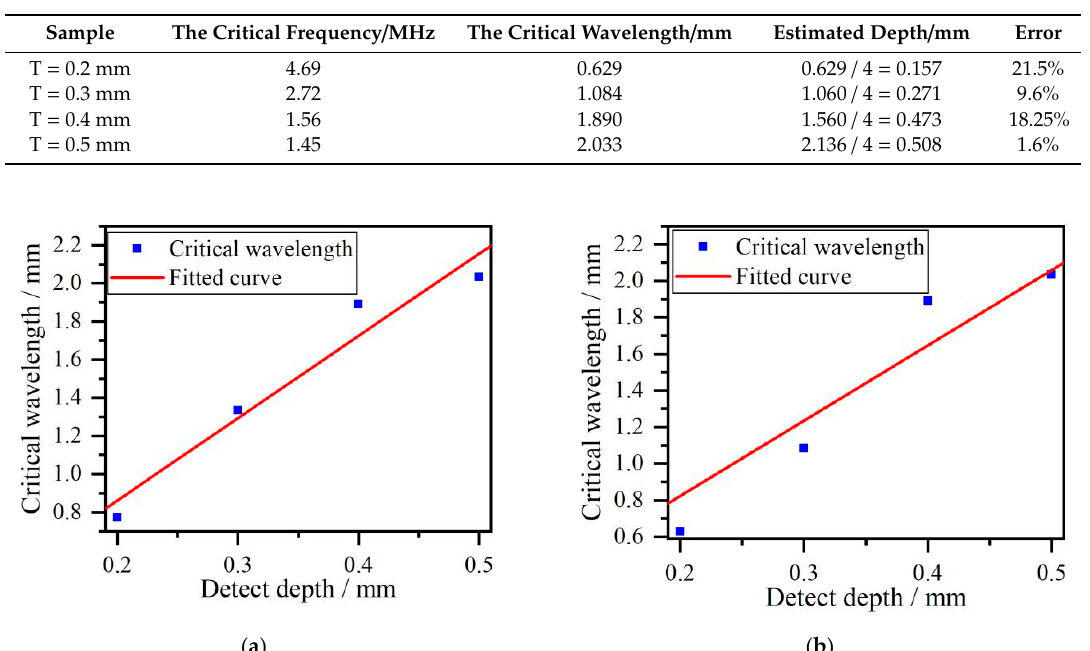
Figure 10. The fitted curves by simulation elements of ( a ) the maximum size 0.2 mm, ( b ) the maximum size 0.5 mm.